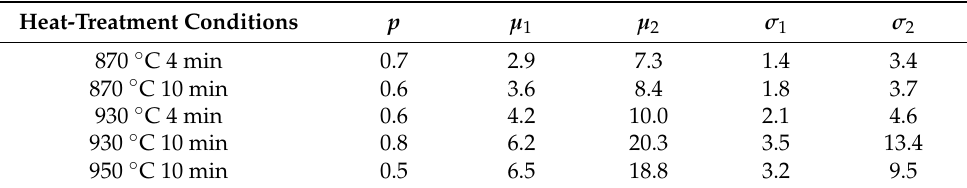
Figure 3. ( a ) The descending cumulative distribution function (CDF) and ( b ) the probability density function of the prior austenite grain (PAG) size in the low-carbon fully martensitic steel following five heat-treatments. The legend is the same for ( a , b ). Table 1. Parameters of the bimodal fit (Equation (1)) to the probability density plots of the five heat-treated materials shown in Figure 3b.